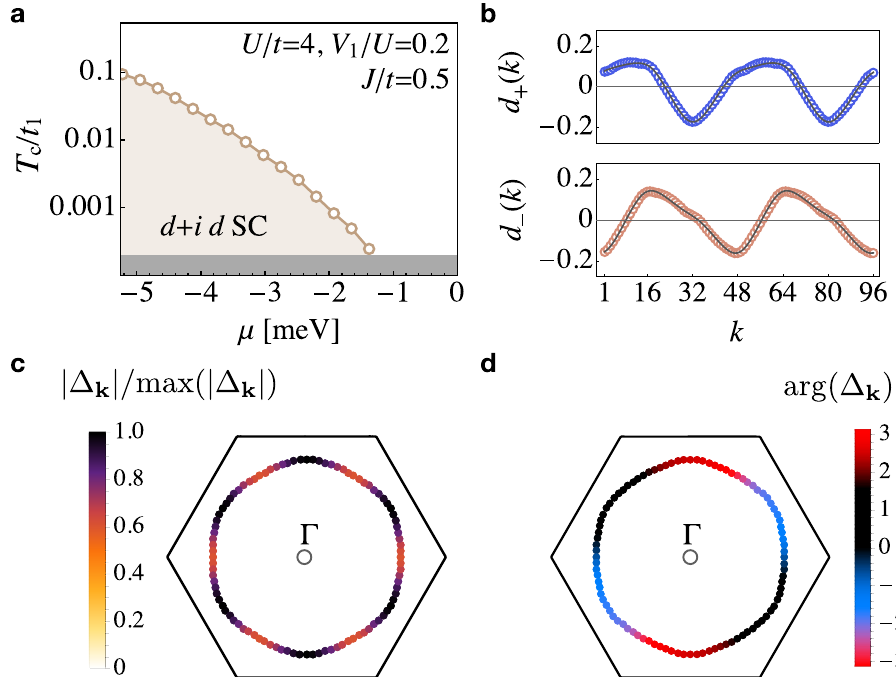
Fig. 3 Effect of exchange coupling. a Filling-dependent critical temperature for a sizable exchange coupling J / t = 0.5. The exchange coupling generates a d -wave instability, which indicates a chiral d + i d ground state. b Superconducting form factors d ± ( k ) extracted from V ( k 1 , k 2 , k 3 , k 4 ) which exhibit a large overlap with a linear combination of nearest-neighbor lattice harmonics d 1 , d 2 (solid gray lines) de fi ned in the text. Their chiral superposition d ± i d fully gaps the Fermi surface with the gap function Δ ( k ) shown in the lowest panels ( c , d ). The phase winds twice around the Fermi